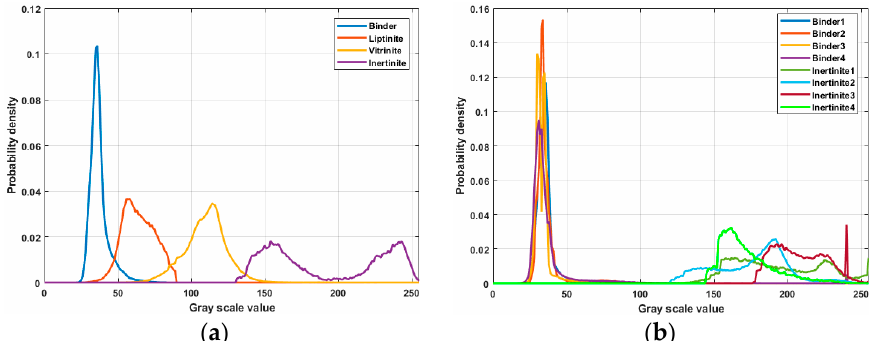
Figure 2. Comparison of gray scale distributions corresponding to different maceral groups and the binder. ( a ) Gray scale distributions of maceral groups and the binder in one coal sample; ( b ) the difference in the gray scale distributions across 4 coal samples. For simplicity, we only show the curves corresponding to binder and inertinite in ( b ).